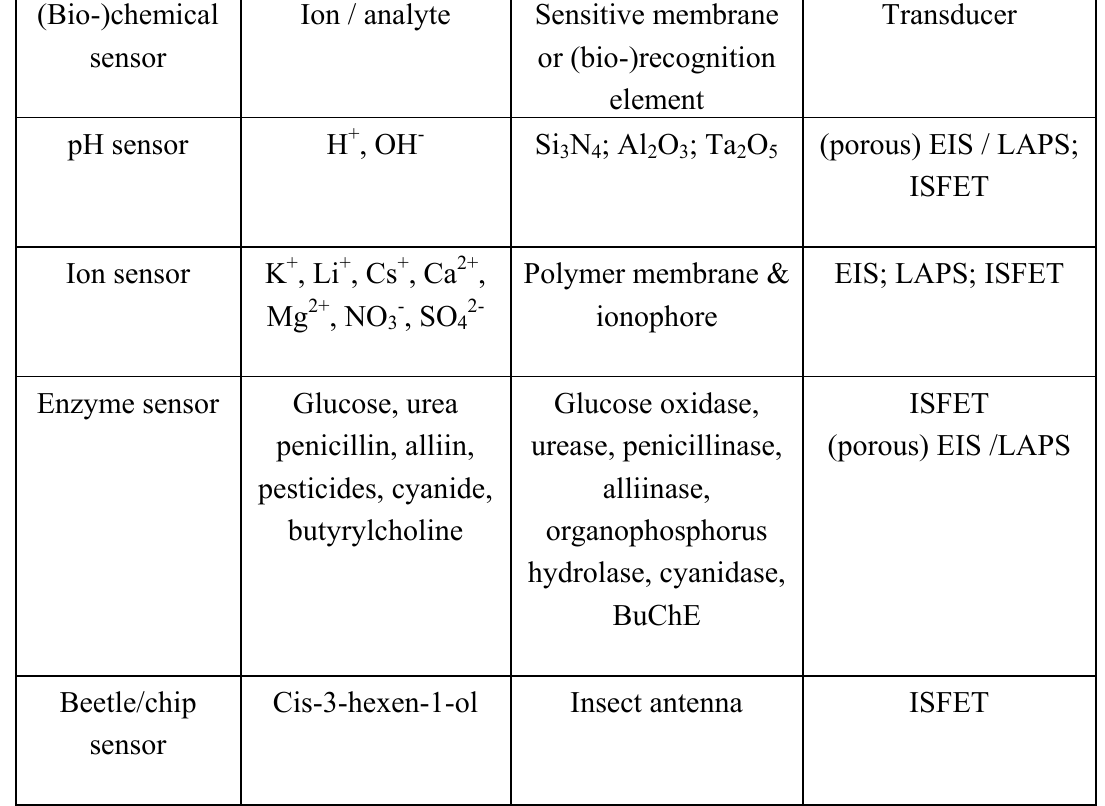
Table 1. Summary of developed (bio-)chemical sensors: EIS, LAPS, ISFET.